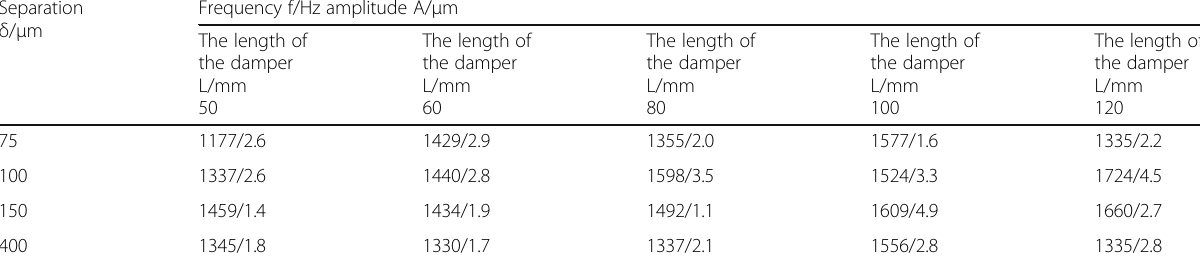
Table 1 Field test raw